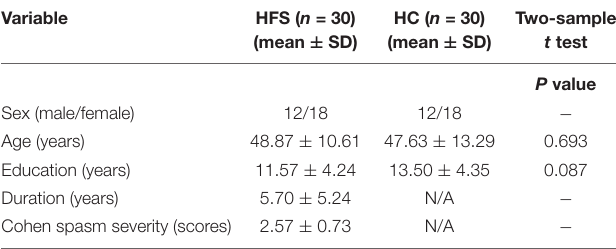
TABLE 1 | Demographic and clinical characteristics of participants.